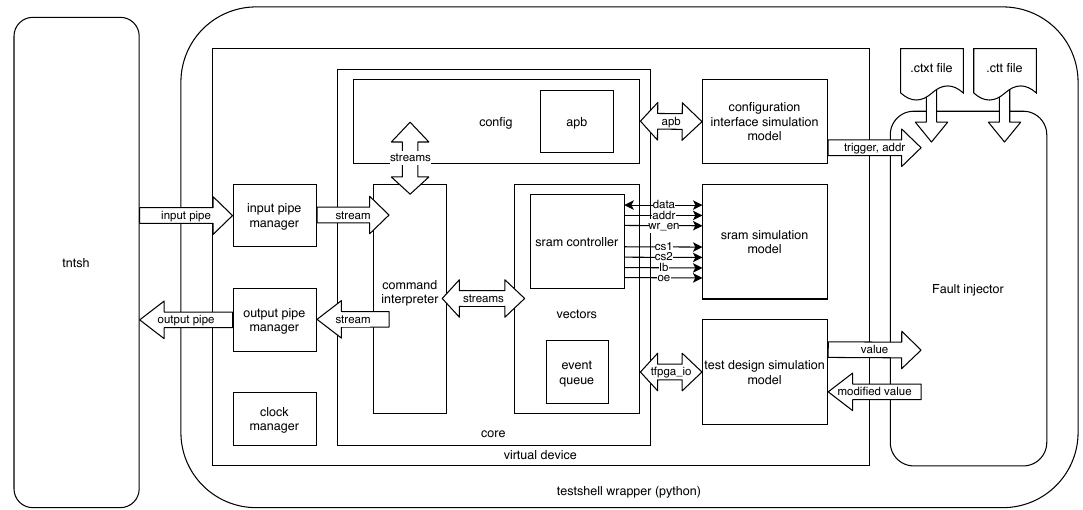
Figure 1. Firmware architecture of the virtual device and communication with